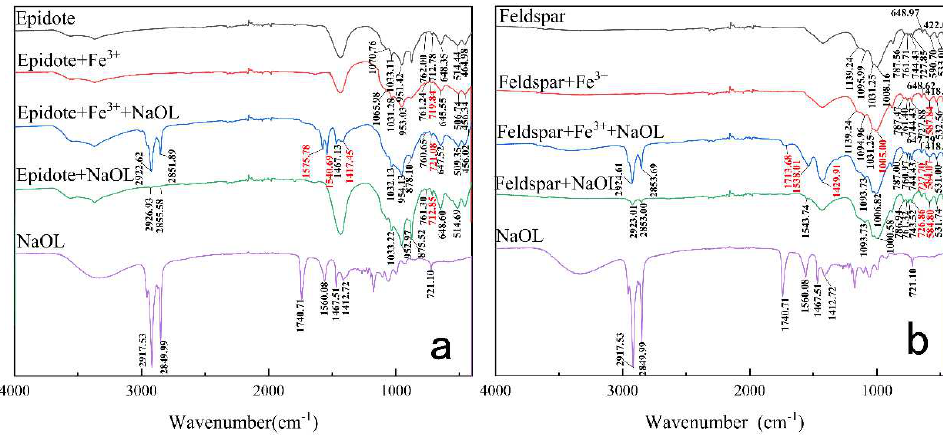
Figure 7. FTIR spectra of epidote ( a ) and feldspar ( b ).